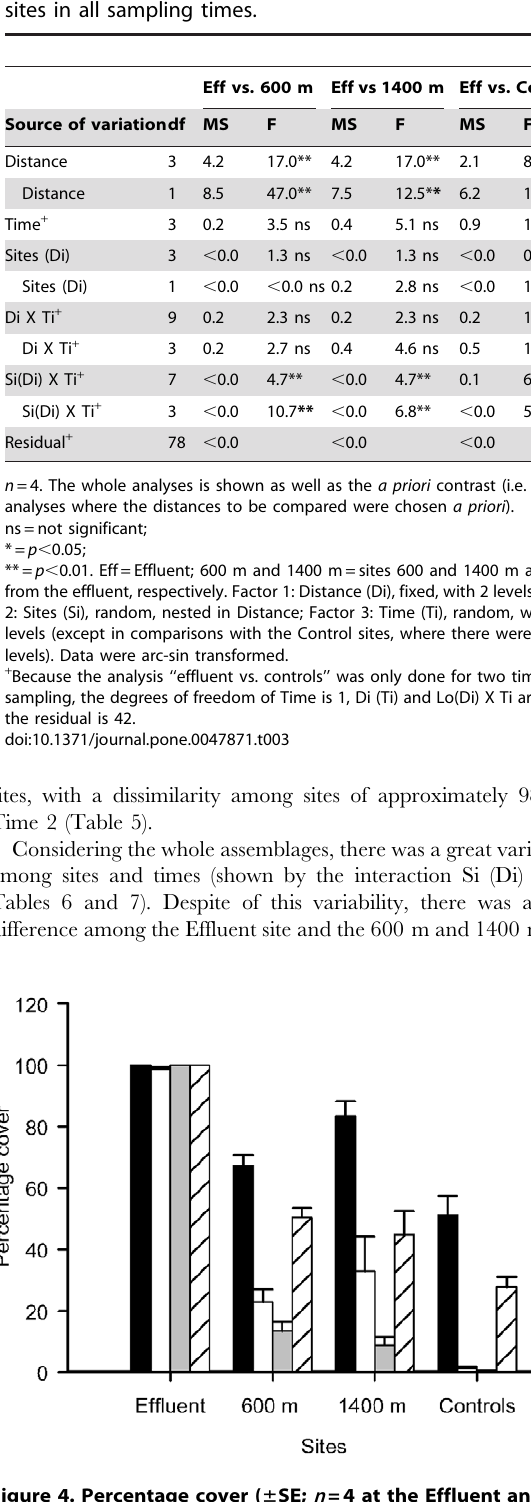
Table 3. Asymmetrical univariate analyses of variance of the percentage cover of biofilm on panels submerged in different sites in all sampling times.